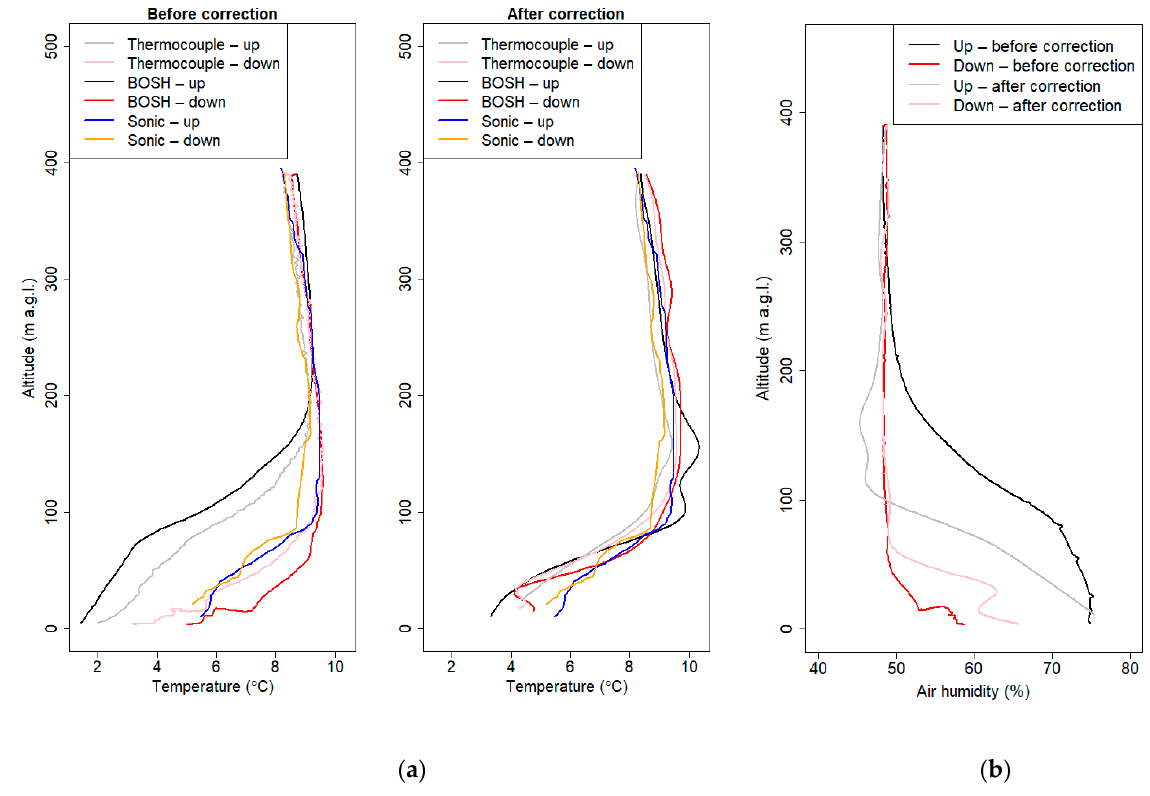
Figure 6. Vertical profiles of the atmosphere before and after correction method—flight at 7.3.2019 6:11 UTC: ( a ) air temperature; ( b ) air humidity.